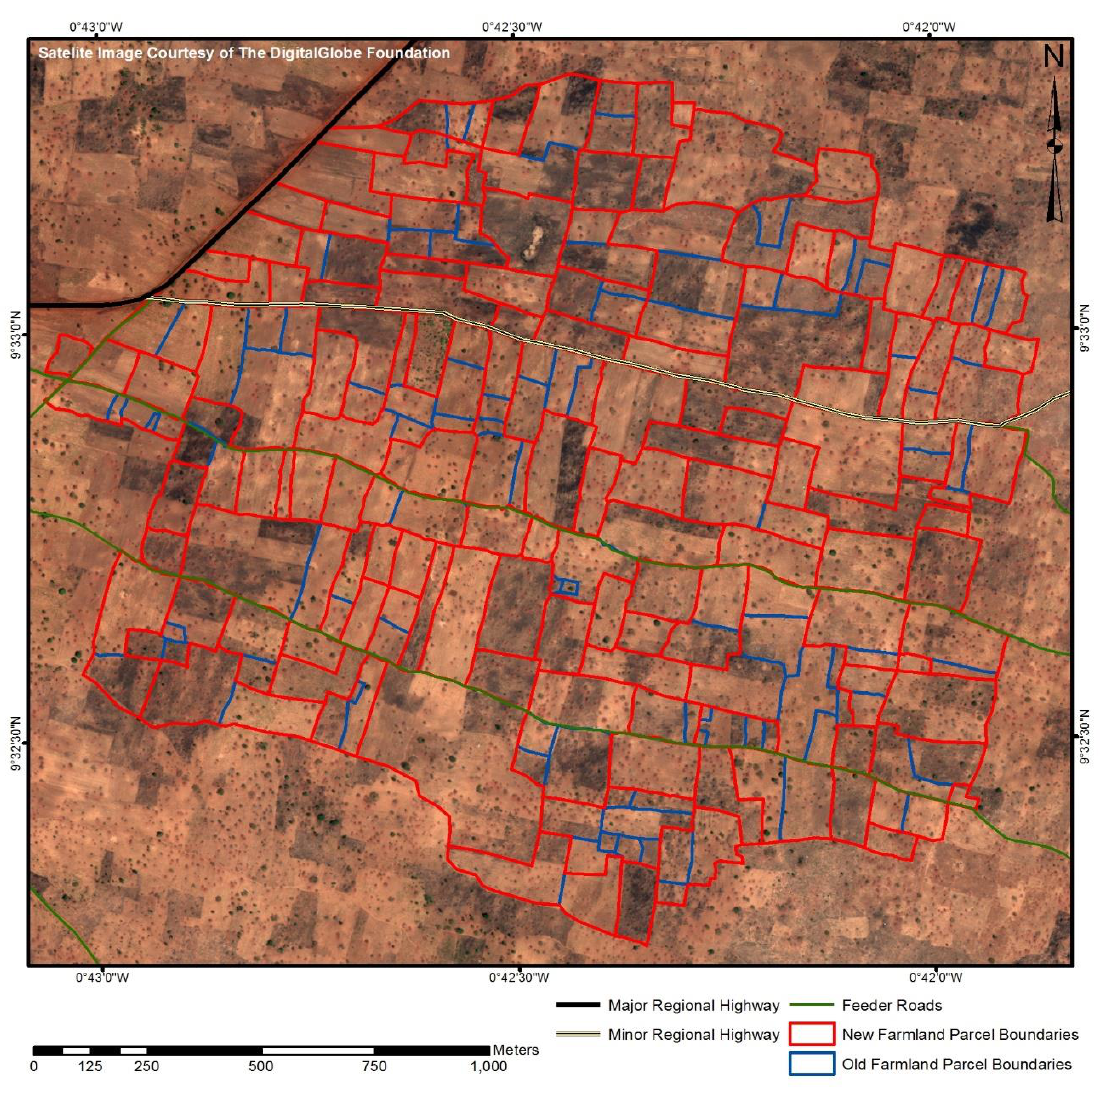
Figure 9. Parcel arrangements before and after land reallocation.